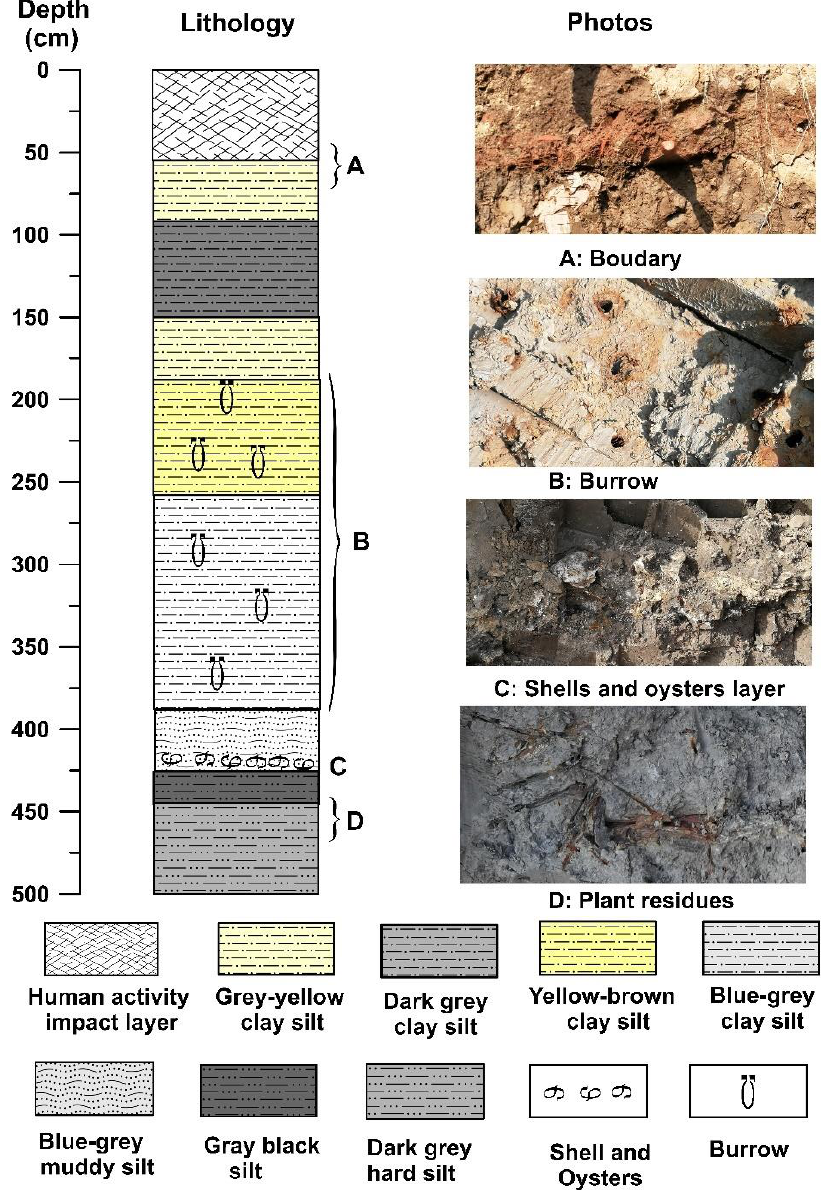
Figure 2. Lithological characteristics of GX profile in Subei Basin.